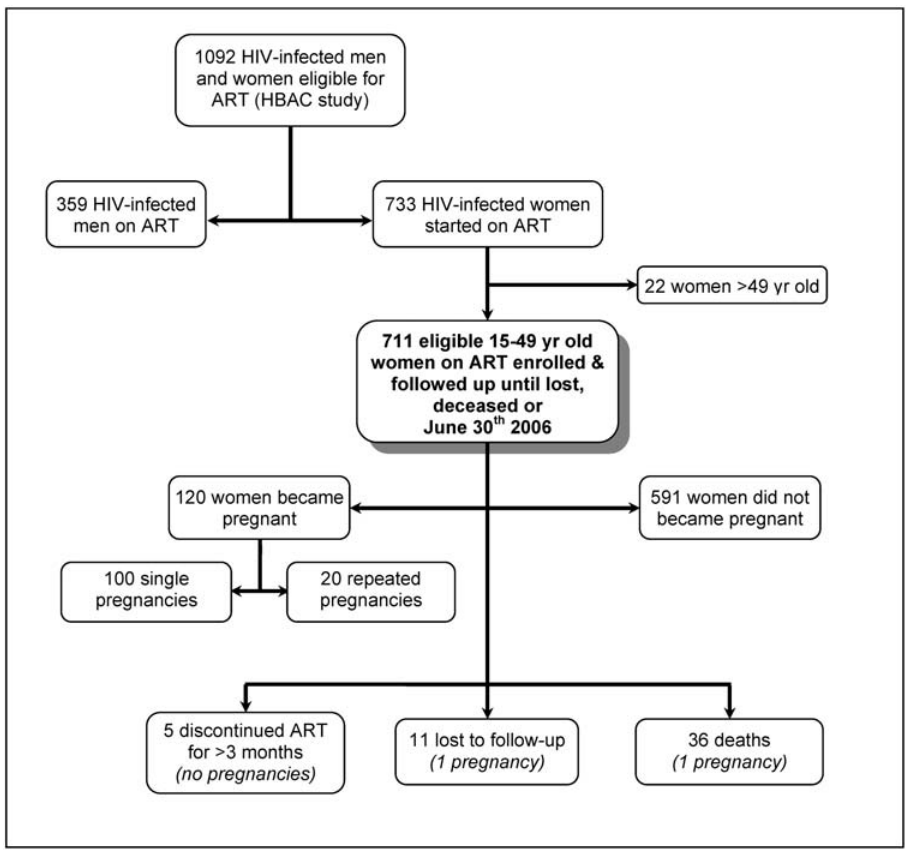
Figure 1. HBAC pregnancy sub-study enrolment and follow-up flow chart.